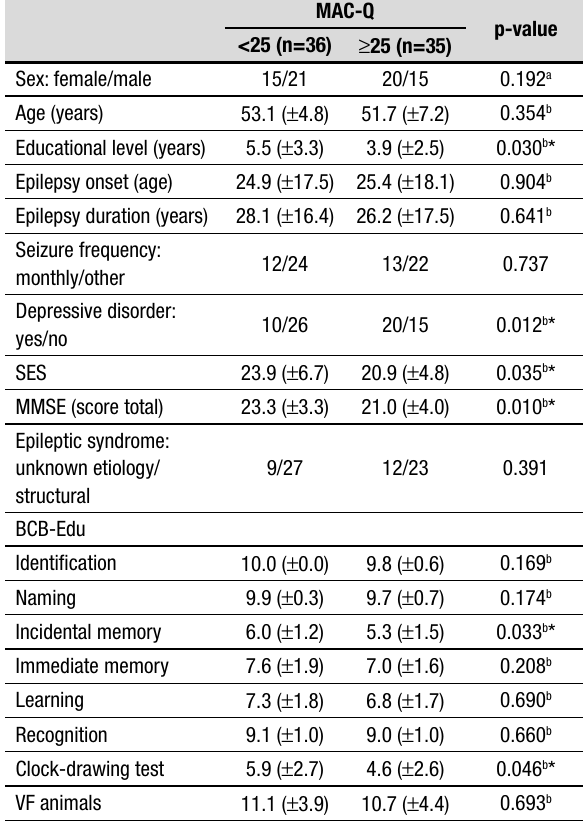
Table 2. People with epilepsy clinical and cognitive data and Rosenberg Self-Esteem Scale scores according to their Memory Complaint Questionnaire scores (<25 or ≥